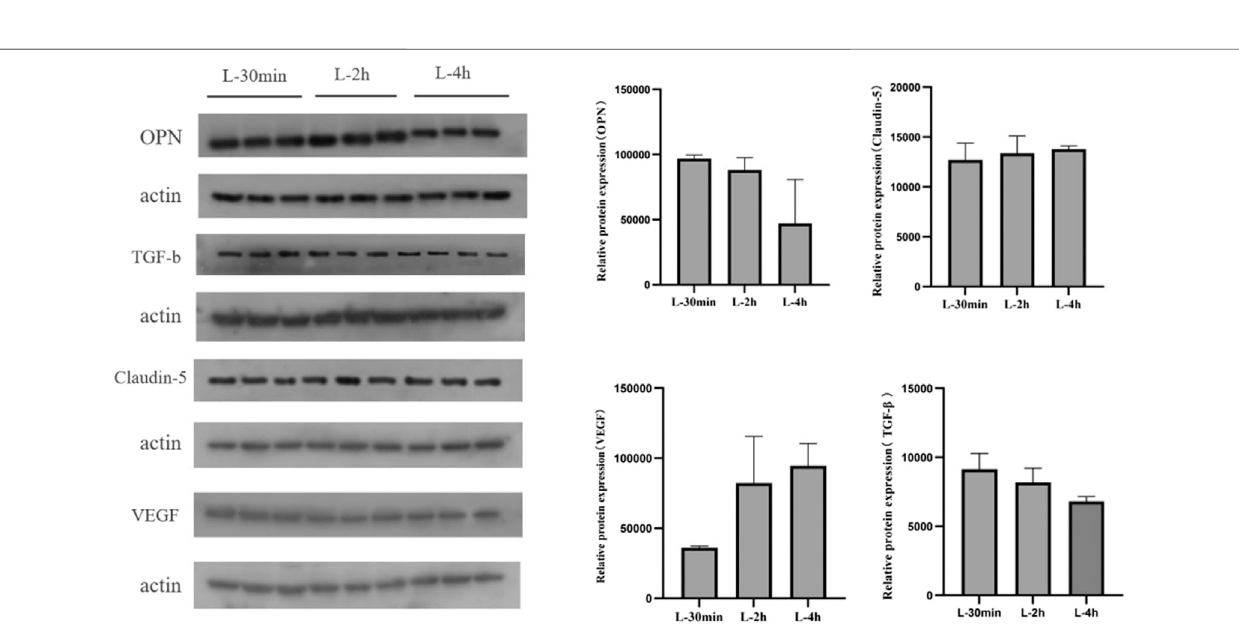
Frontiers in Pharmacology |